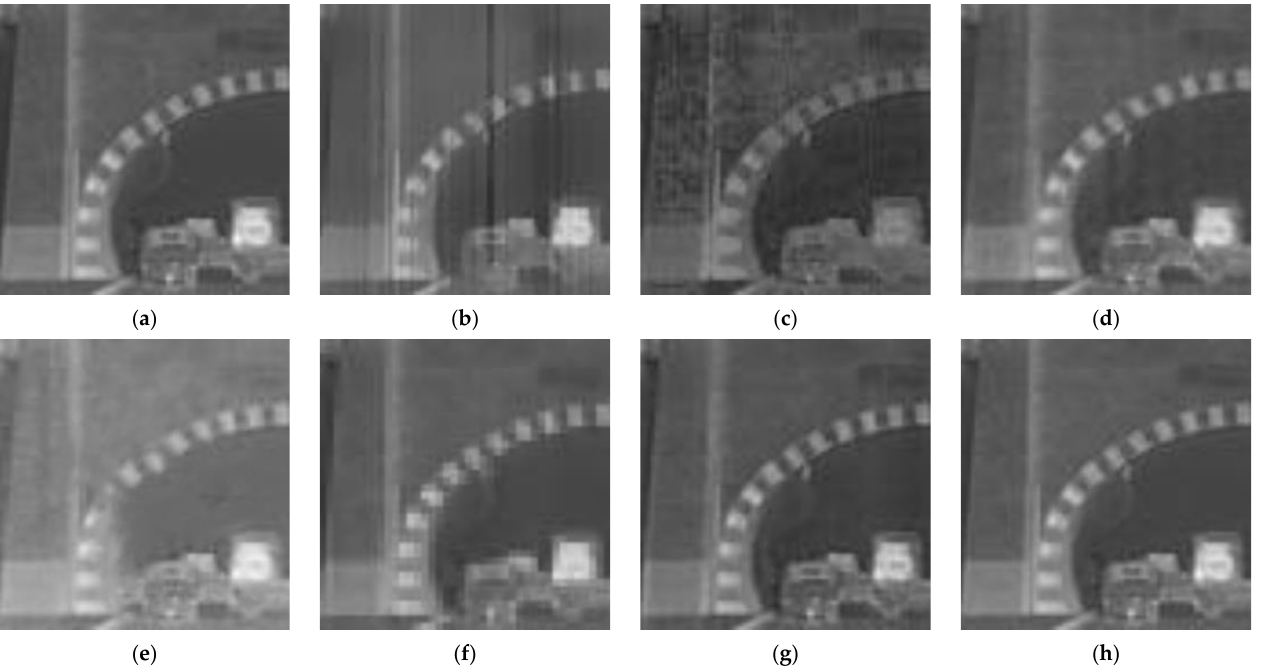
Figure 19. Correction results of Window 2. ( a ) Ideal result; ( b ) BFTH algorithm correction result; ( c )